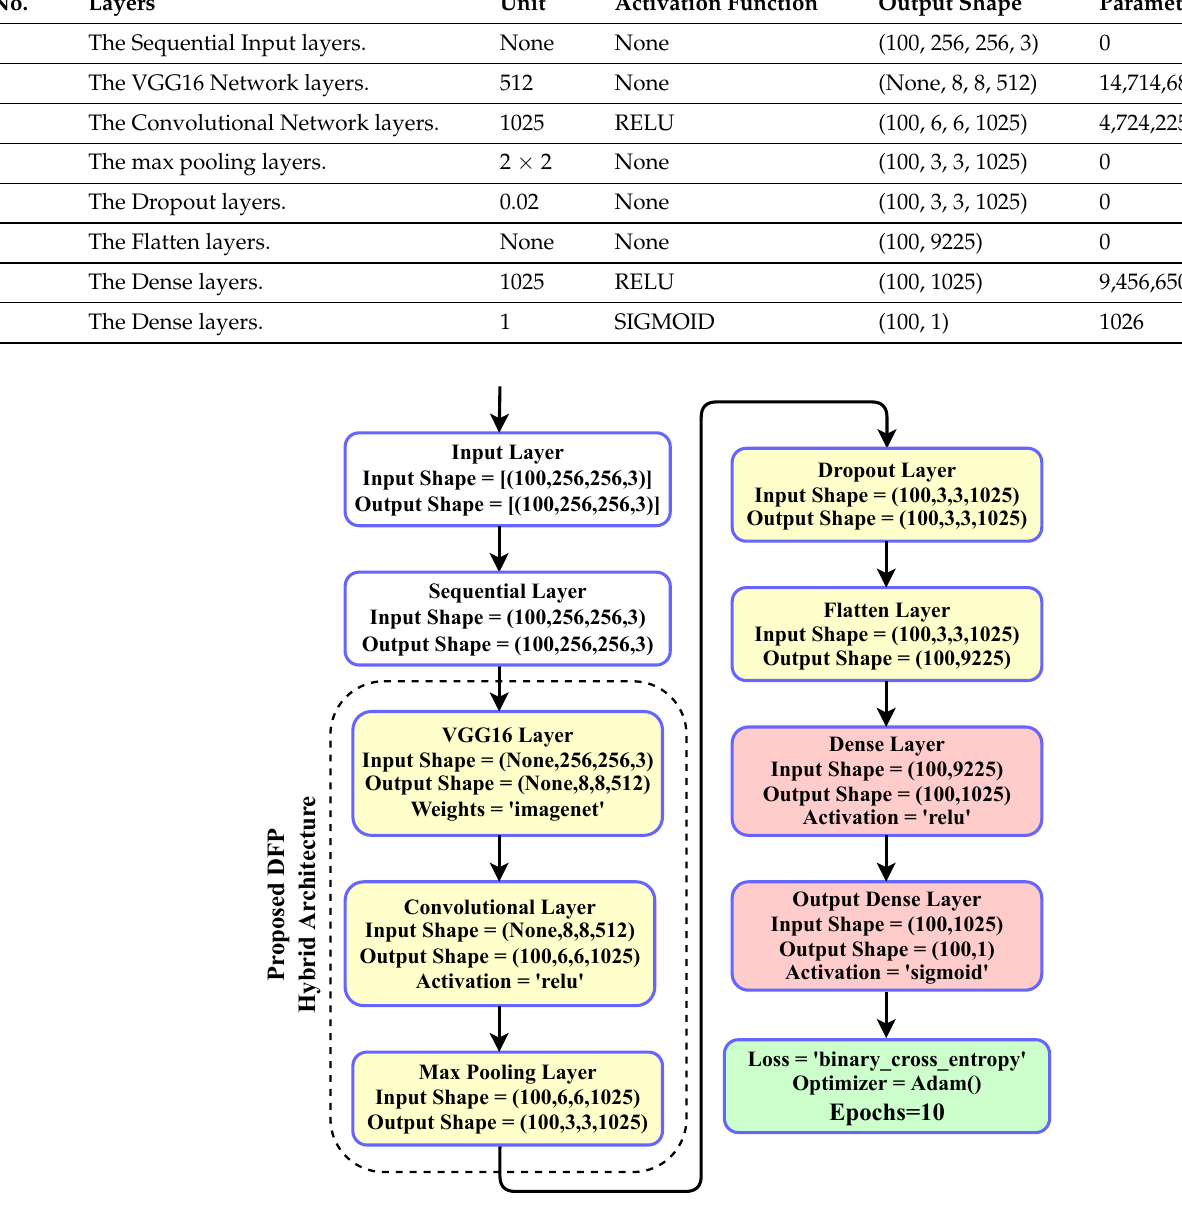
Figure 3. The novel proposed DFP model architectural